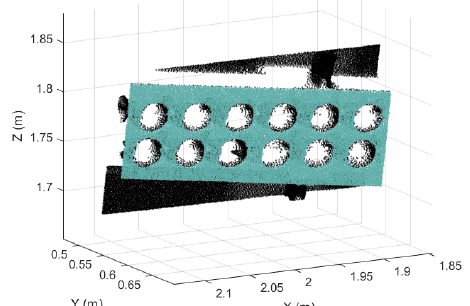
Figure 7: Planar segment (blue) detected from the point cloud (black), removes wing skin surface and interior of template holes